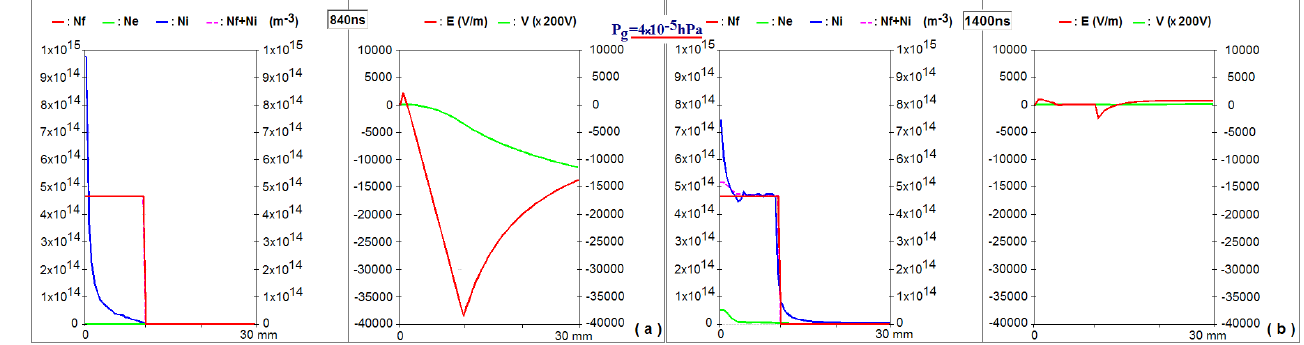
gas pressure: 4 (cid:7) 10 (cid:2) 5 hPa . 2